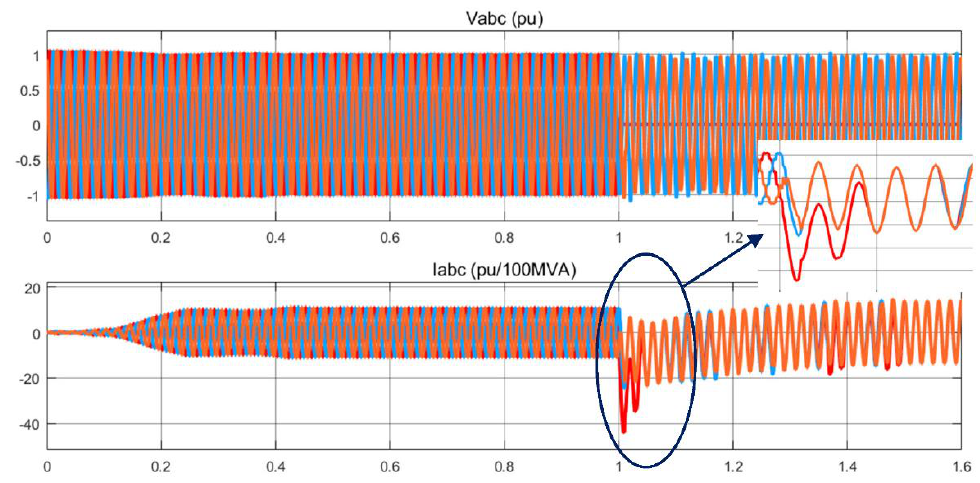
Figure 13. The absence of fault at both converters in three-phase voltage and current signals.